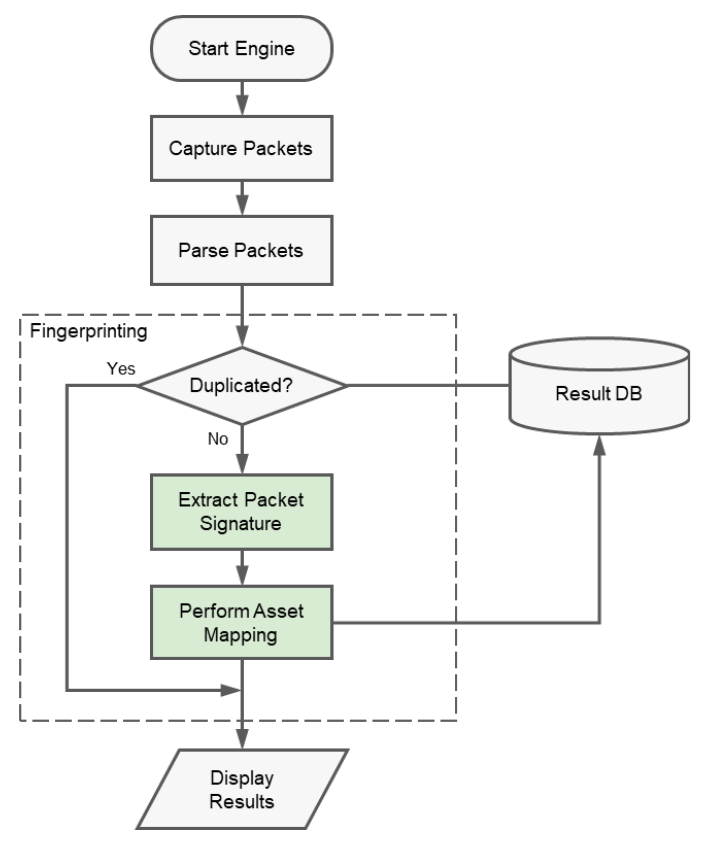
Figure 7. Detection process for the test environment packet.